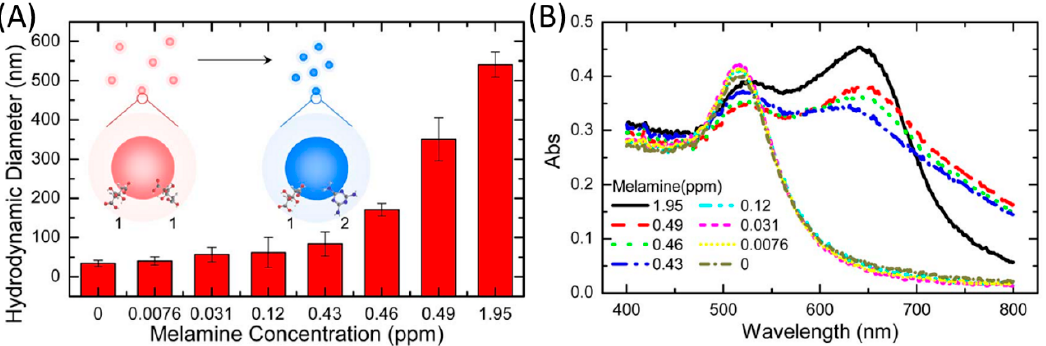
Figure 5. ( A ) Dynamic light scattering (DLS) demonstration of melamine concentration-dependent increases in particle size and ( B ) spectrophotometric demonstration of color shift. Reprinted with permission from Applied Physics Letters, 2010, 96, 133702. Copyright (2010) American Institute of Physics.